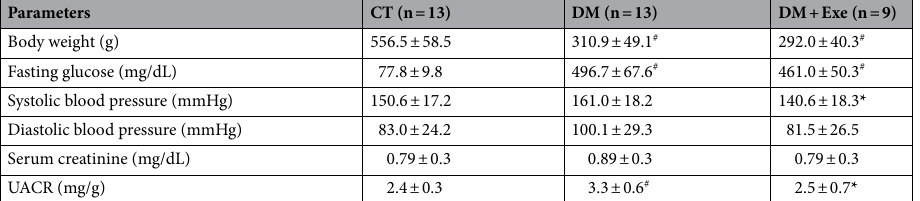
Table 1. Physical and metabolic parameters of the experimental groups following eight weeks of aerobic exercise training. Values are means ± SE. UACR, urinary albumin-to-creatine ratio. CT, nondiabetic rats; DM, sedentary diabetic rats; DM + Exe, exercised diabetic rats. # p < 0.05 vs. CT; * p < 0.05 vs.